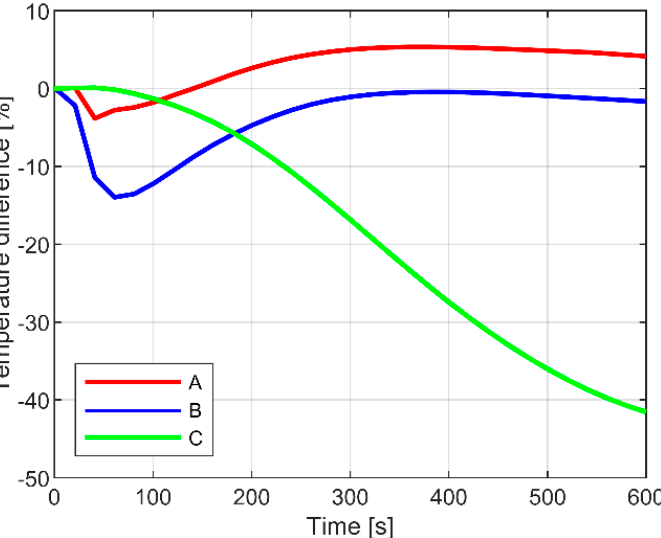
Figure 14. Temperature sensitivity study at selected control points (ABAQUS/Standard).